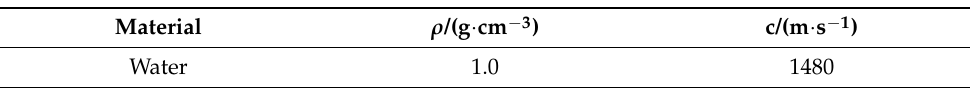
Table 4. Physical properties of steel Q235.